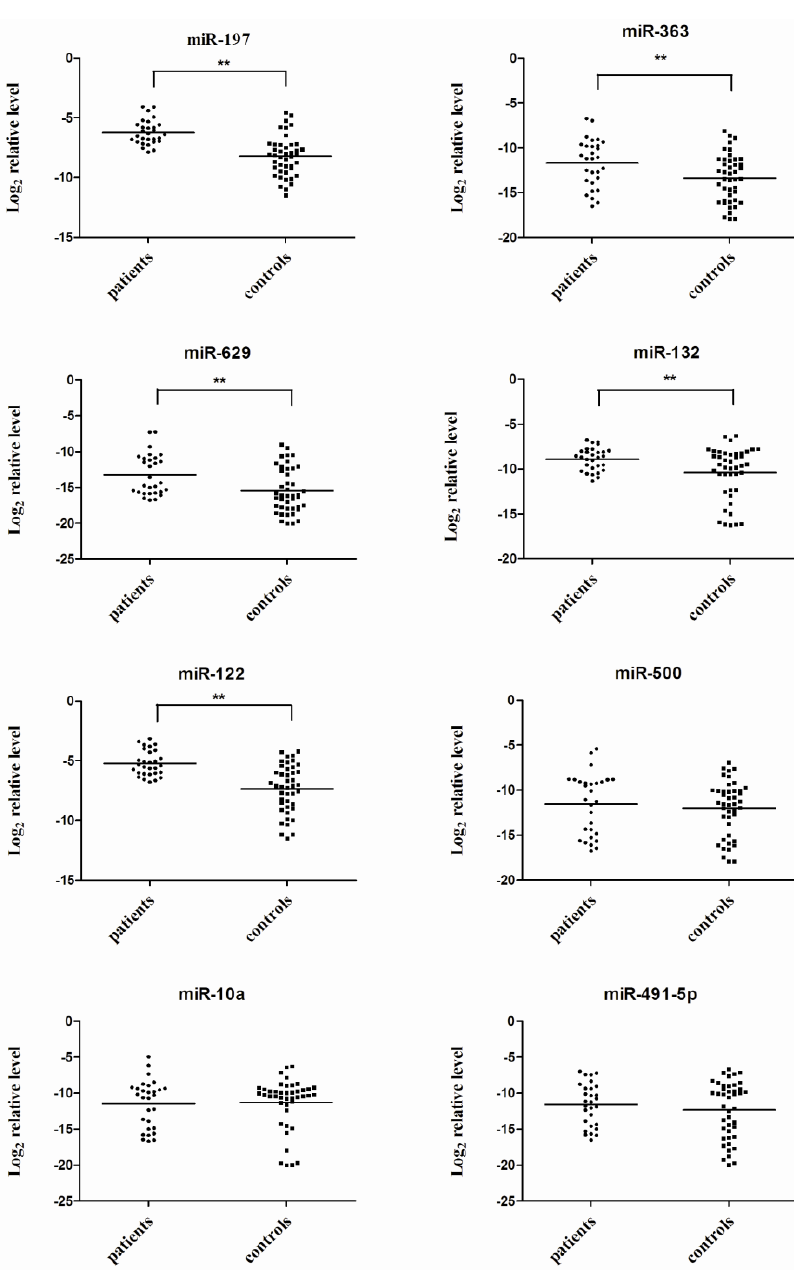
Figure 1. Eight serum miRNA levels in varicella patients and healthy controls were selected for verification using real-time qRT-PCR in individual varicella patients ( N = 29) and healthy controls ( N = 43). Serum levels of miR-197, miR-363, miR-629, miR-132 and miR-122 were significantly higher in varicella patients compared with those in the control group ( ** , p < 0.01), while no significant differences were detected in the expression of miR-500, miR-10a and miR-491-5p. Expression levels of the miRNAs are normalized to cel-miR-238 (Log relative 2